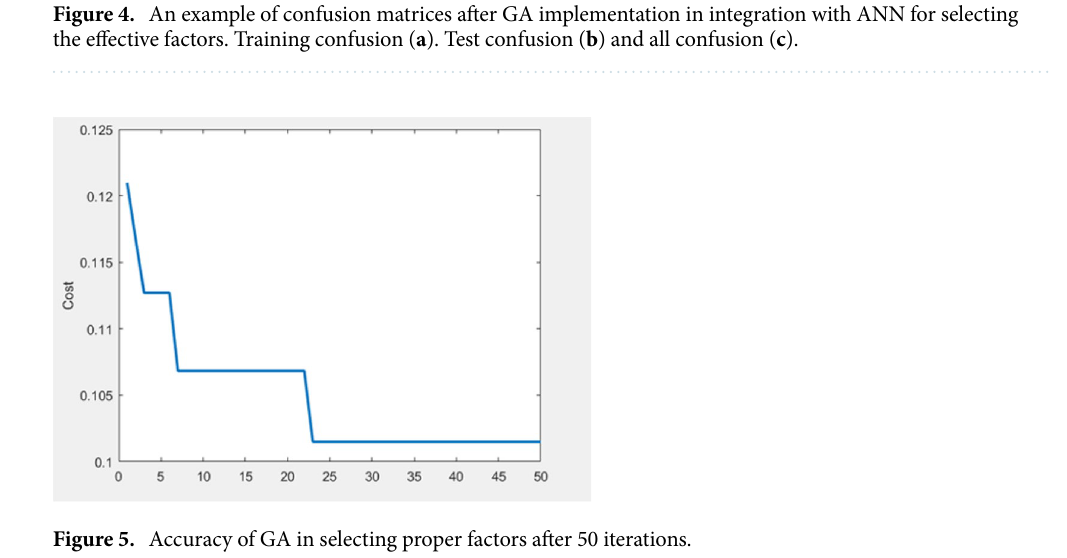
Figure 5. Accuracy of GA in selecting proper factors after 50